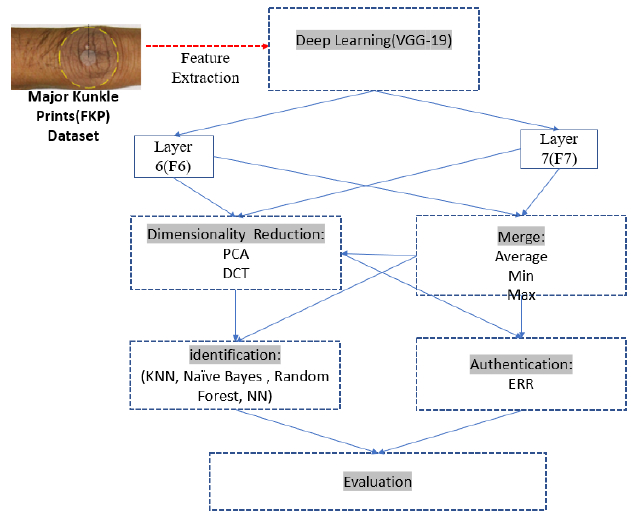
Figure 2. The Proposed FKP recognition Model .